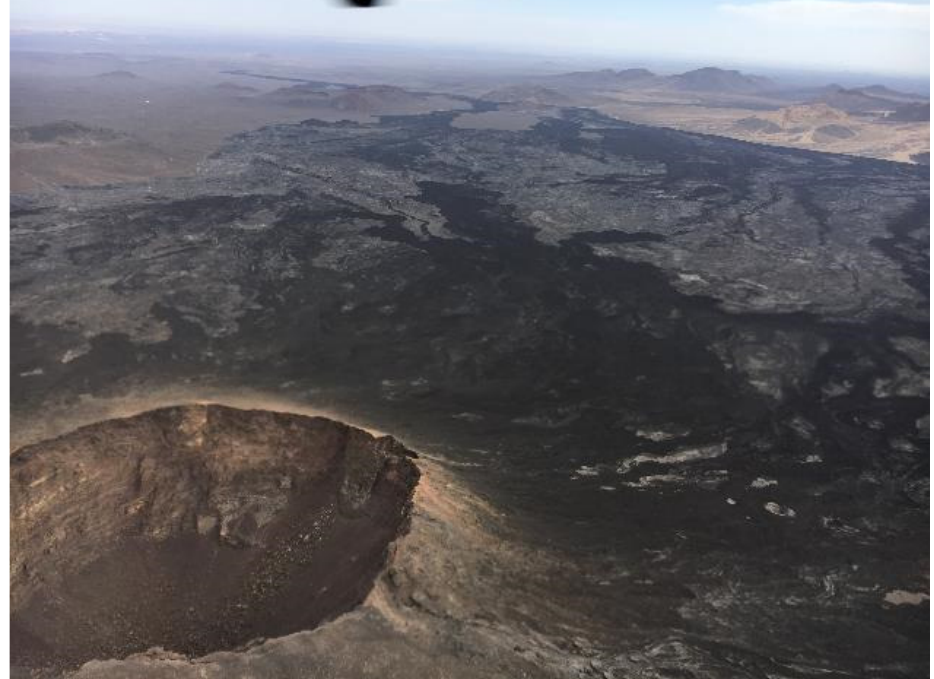
Figure 8. Jabal Quidr’s eastern side with the complex lava flow field and the deep crater of the cone. Lava flows were partially fed from overfill of the crater and some side fissures. Lava flow outpouring and draining triggered crater floor collapse and the generation of the deep crater. The crater is about 250–300 m across.